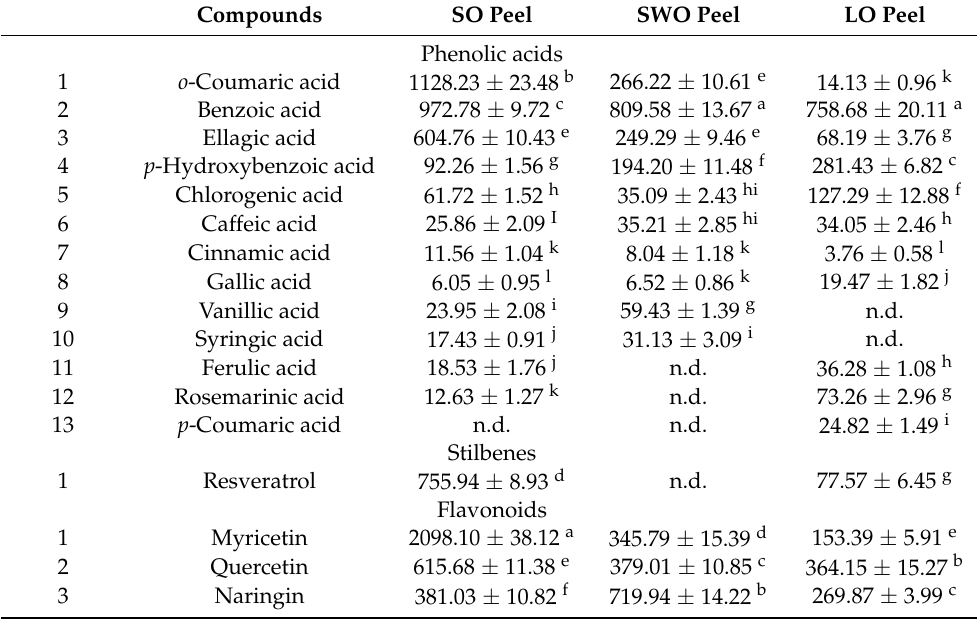
Table 1. Profiles of polyphenolic compounds ( µ g/g DW) in different citrus peels. Compounds SO Peel SWO